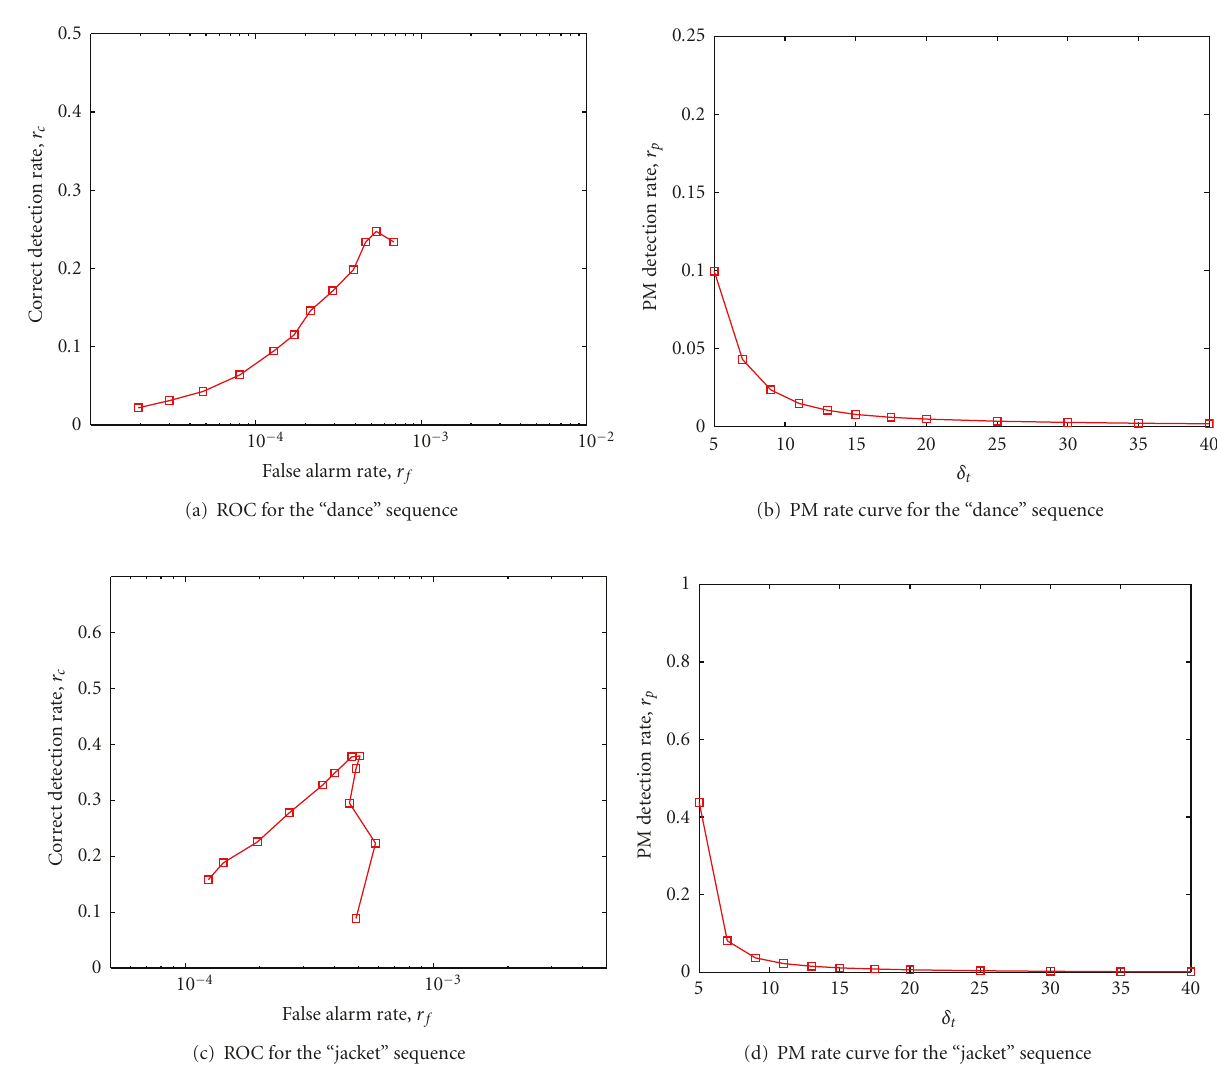
Figure 10: This figure shows ROC and PM rate plots ( r p versus δ t ) for both test sequences obtained from the proposed algorithm using the standard set of